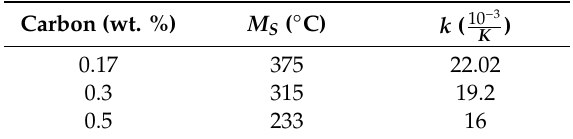
Table 1. Calculated carbon dependent values for M S for steel S156.